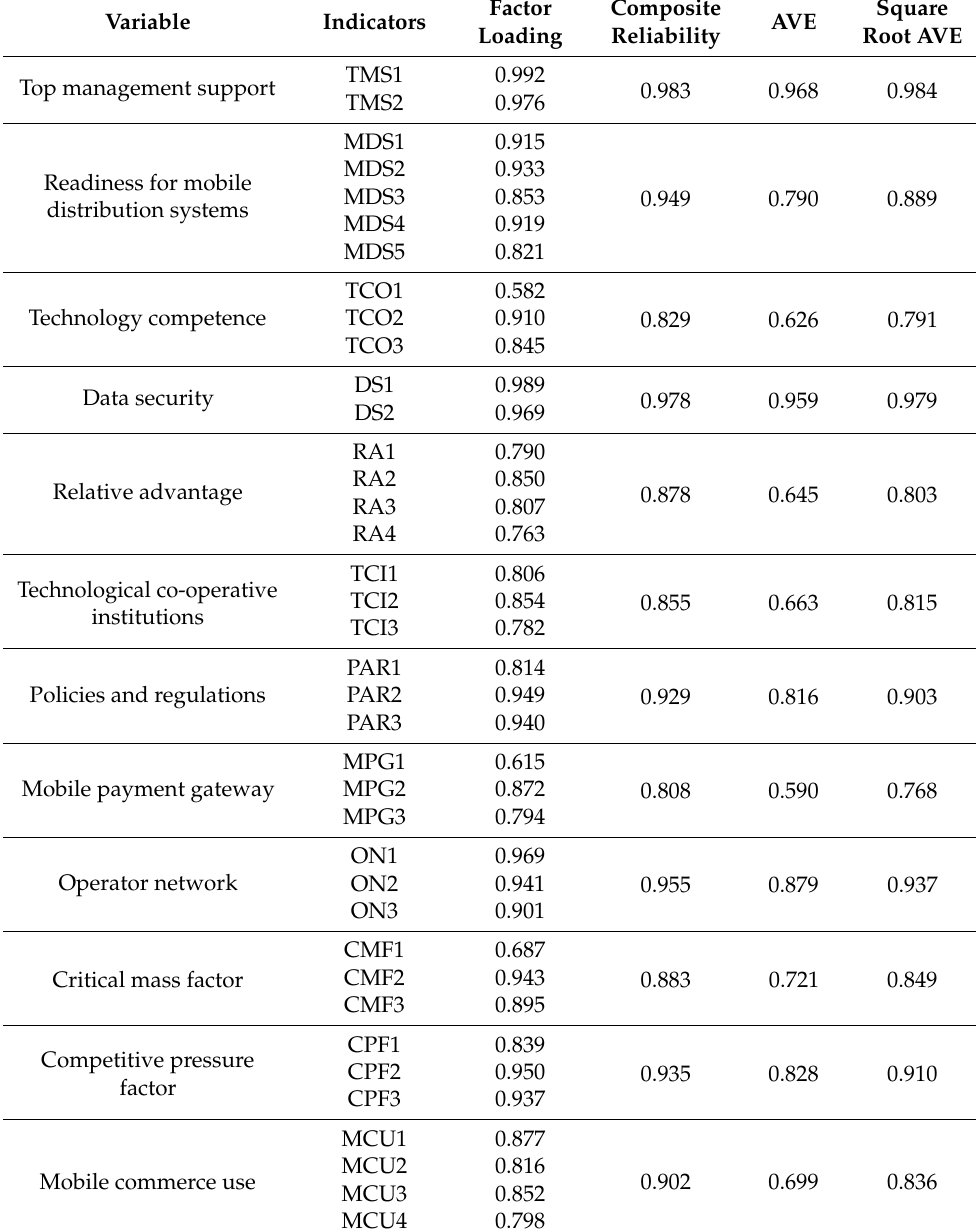
Table 2. Variables: loadings, composite reliability, and